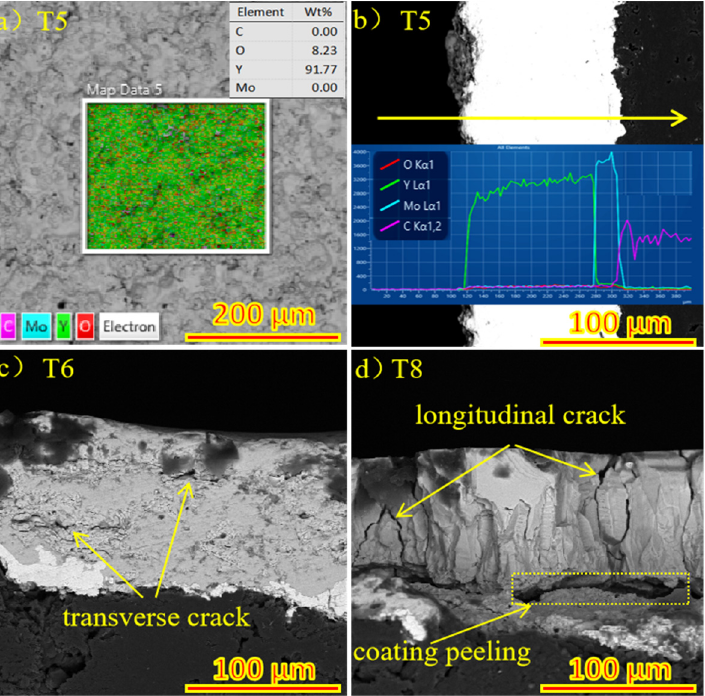
Figure 5. XRD patterns of Y 2 O 3 coated graphite (T0) and laser micromelted Y 2 O 3 coated graphite (T5) and (T9).